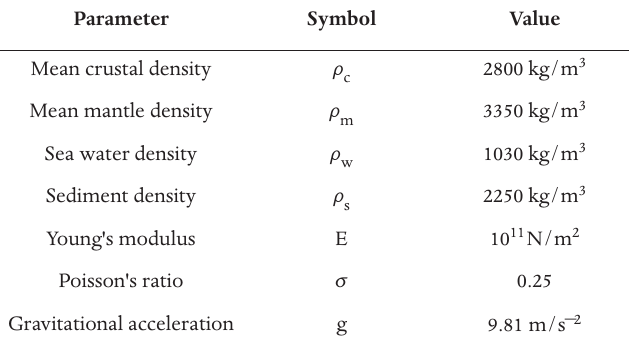
Table 1. Parameters used in the